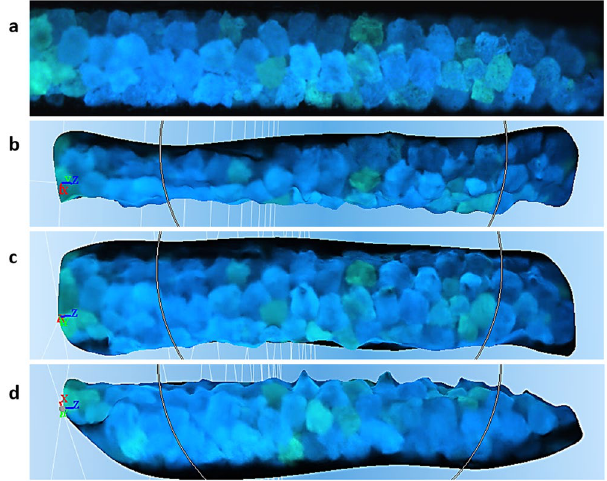
Figure 4. 3D-360° photogrammetry for studying advanced shape and particle packing. Grains of strontium aluminate (60–90 µ m) inside a soda-lime glass capillary tube (wall thickness: 10 µ m; width: 300 µ m; length: 1,550 µ m) were imaged during semi-rotation. ( a ) Real image in UV in the dark, as described in Fig. 1, right. ( b – d ) 3D reconstructed model, viewed at − 90°, − 10° and + 80°, respectively.